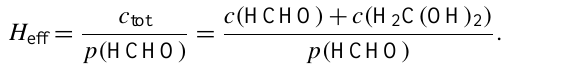
Table 5. Temperature-dependent terms and their analytical deriva- tives. Here, C , C 1 , and C 2 are the empirical fit parameters defining ln (H) . See Sect. 2.6 for